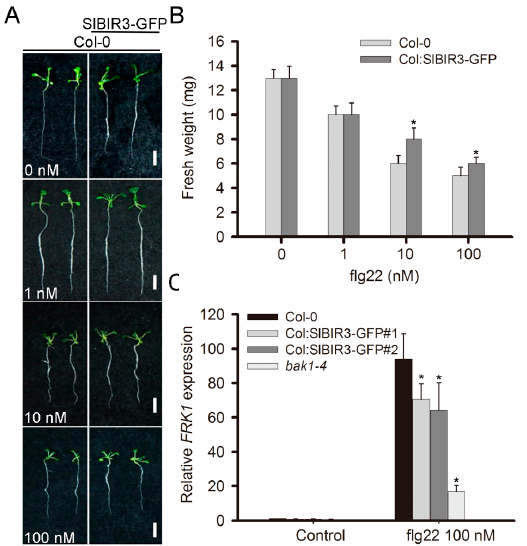
Figure 4. SlBIR3 negative regulates flg22 triggered PAMP responses. ( A ) Phenotypes of Col-0 and SlBIR3-overexpression seedlings (Col-0 background) after flg22 treatment. The photographs show 14-day-old seedlings that were treated with different concentrations of flg22 for 7 days. Scale bars, 10 mm; ( B ) Seedling growth inhibition induced by flg22 is shown in ( A ). At least 12 seedlings were measured; ( C ) The relative expression level of FRK1 was measured by real time quantitative RT-PCR, with ACTIN2 used as the reference gene. 14-day-old seedlings were treated with 100 nM flg22 for three hours. Data indicate mean values ± SD and the asterisks indicate significant differences compared to wild-type Col-0, according to a Student’s t test (* p < 0.05). Experiments were performed three times with similar results.